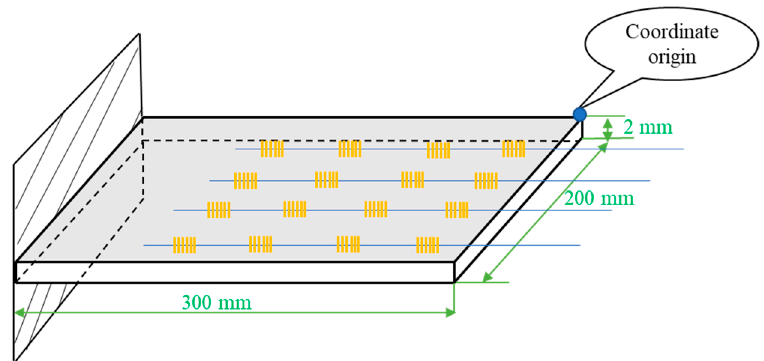
Figure 2. Sensor layout diagram.